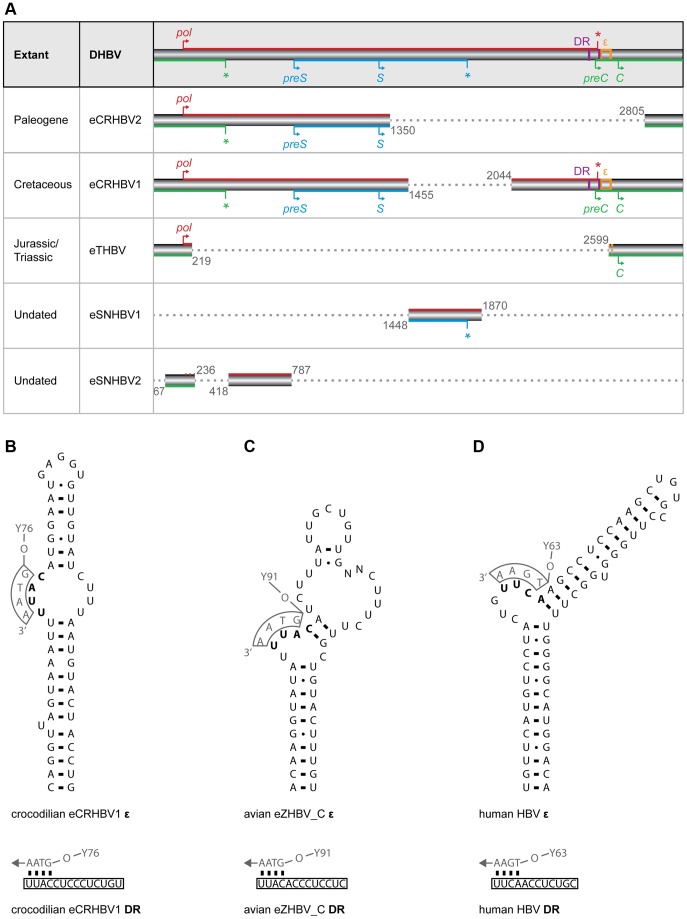
Non-avian hepatitis B paleovirus genome organization and features of viral replication.(A) The fragments of the crocodilian and turtle HBV EVEs described herein extend over ∼81% (eCRHBV1), ∼52% (eCRHBV2), ∼21% (eTHBV), ∼18% (eSNHBV2), and ∼14% (eSNHBV1) of the circular 3,024-bp extant DHBV genome from ducks (AY494851). Genomic regions missing from these fragments are indicated by dashed grey lines. The reconstructed start (arrow) and stop (asterisk) codon positions for the ORFs of the polymerase protein (pol; red), the presurface/surface protein (preS/S; blue), and the precore/core protein (preC/C; green) indicate a highly similar genome organization among Hepadnaviridae. Genomic features related to viral replication are direct repeats (DR; purple vertical lines) and the RNA encapsidation signal (ε; orange box); these are contained in the crocodilian eCRHBV1 fragment. Comparison of DR sequence and ε RNA secondary structure of this crocodilian HBV EVE (B) with homologous structures in the Mesozoic avian HBV EVE (C) and human HBV [51] (D) shows conservation of the priming bulge (bold), whereas the rest of the stably base-pared ε hairpin structure exhibits little sequence similarity [51] between avian and mammalian HBVs, and also the crocodilian HBV (see also S1 Figure for an alignment of ε sequences). In extant HBVs [51], the conserved tyrosine (Y) residue of the terminal protein domain (numbers indicate the tyrosine amino acid site) of the pol ORF is attached to a DNA primer (grey letters) that binds to the ε priming bulge and the 5′ end of the DR. Arrows depict the direction of minus DNA synthesis.